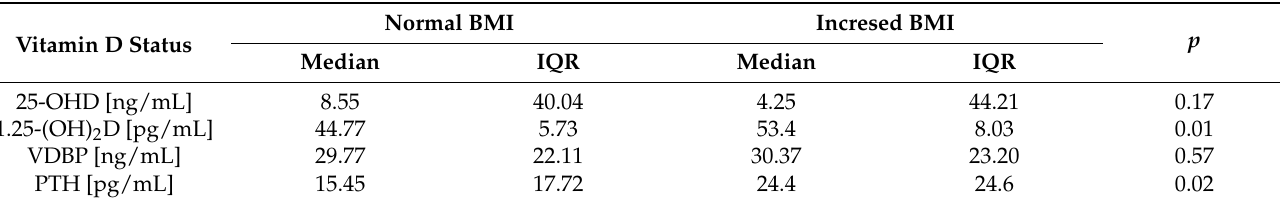
Table 1. Vitamin D status between patients with normal and increased BMI.